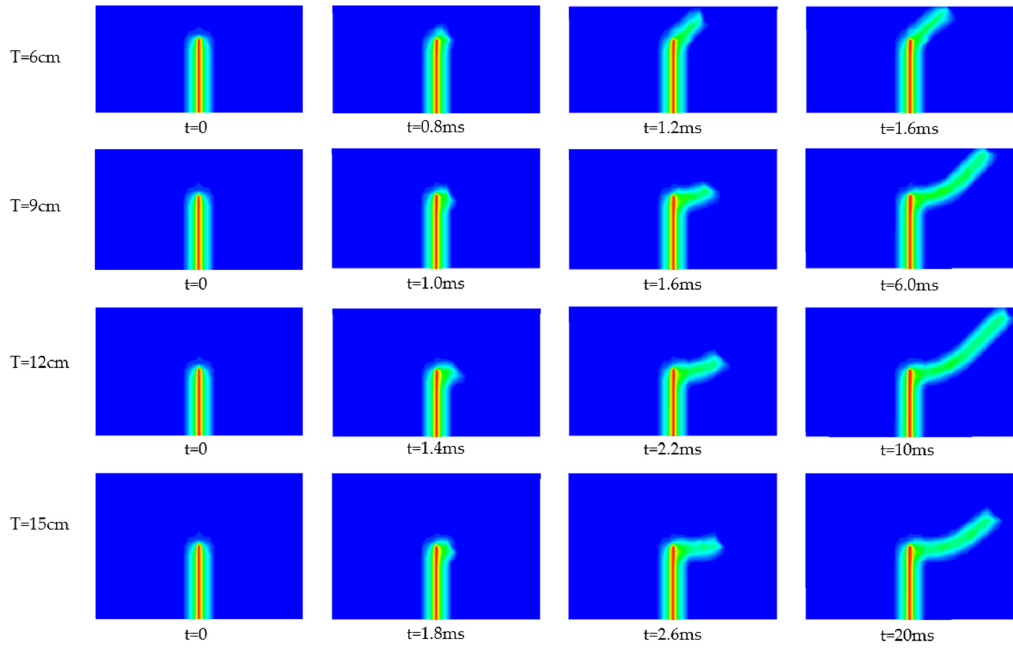
Figure 12. Crack propagation of asphalt pavement with different thicknesses. Table 4. Expansion behavior of reflective cracks in asphalt overlays of different thicknesses.